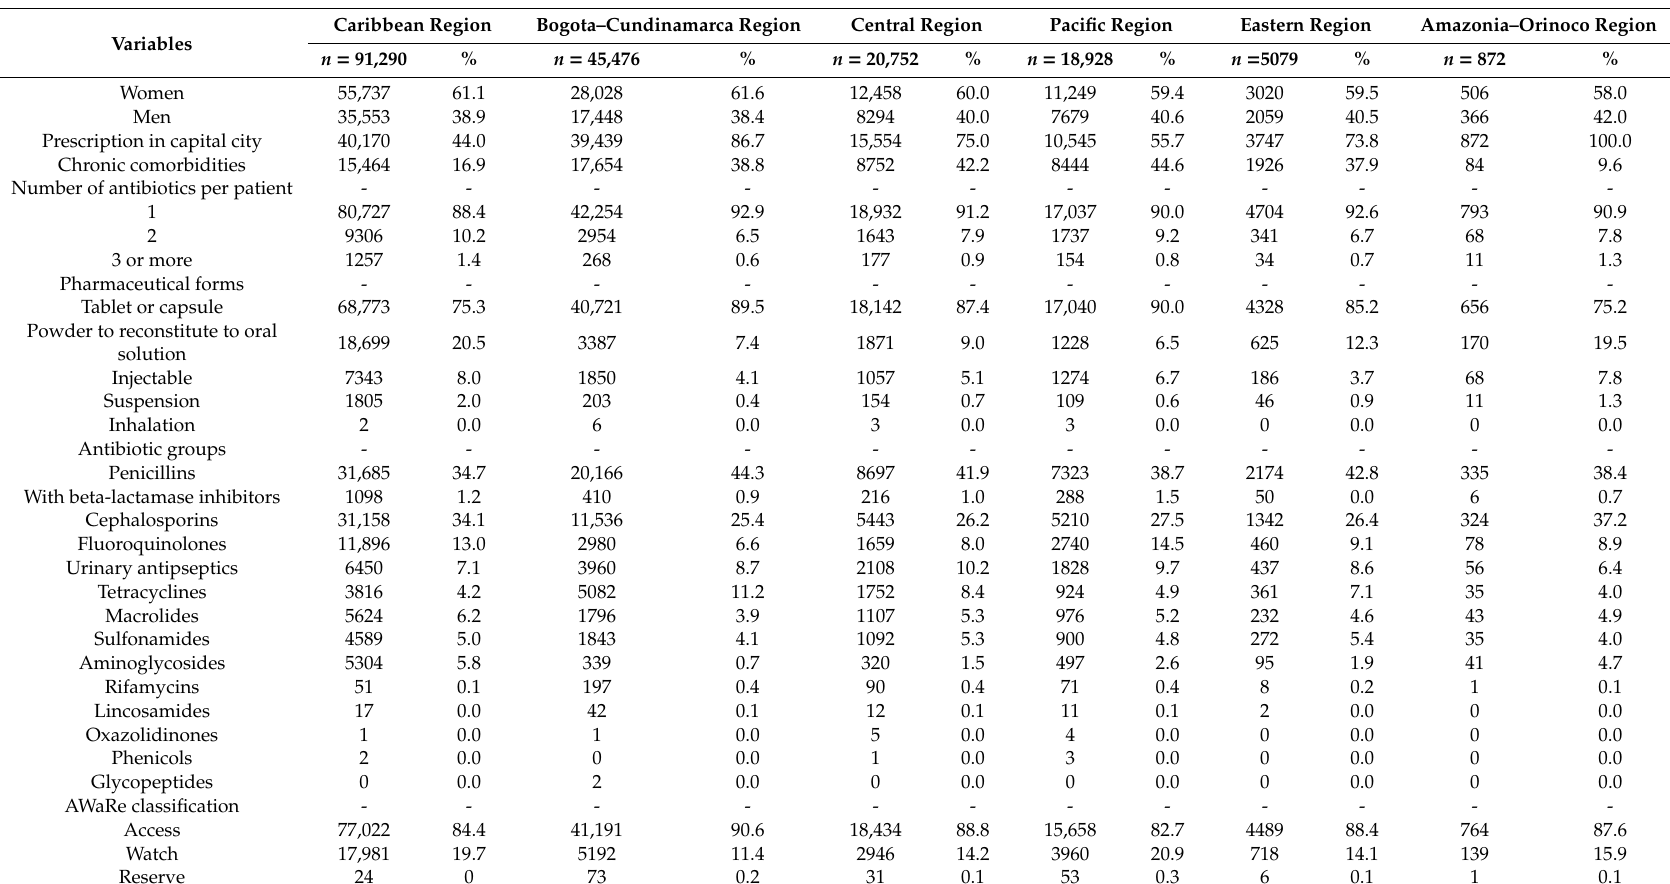
Table 4. Comparison of di ff erent sociodemographic and pharmacological variables of patients who had one or more antibiotic prescriptions according to the Colombian geographic